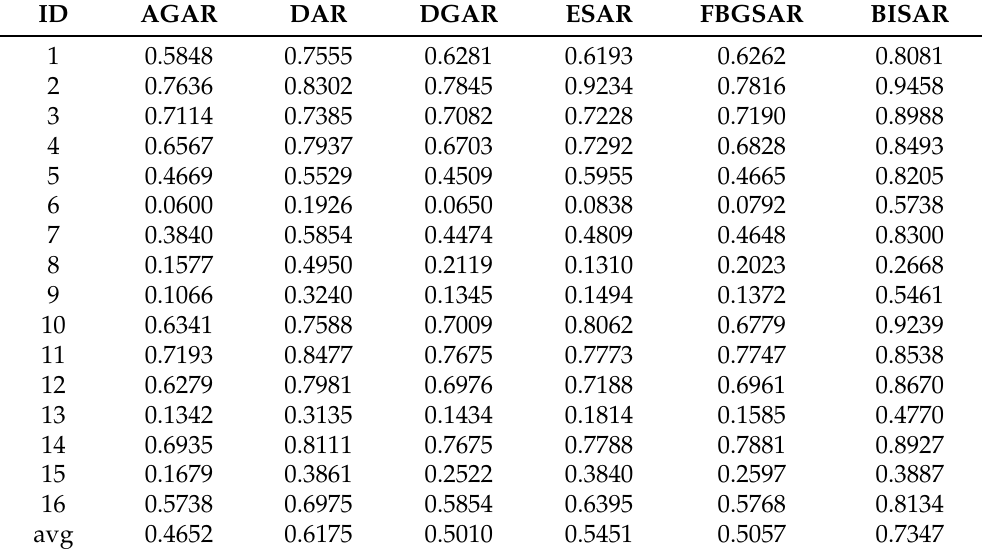
Table 3. The stabilities of reducts (label